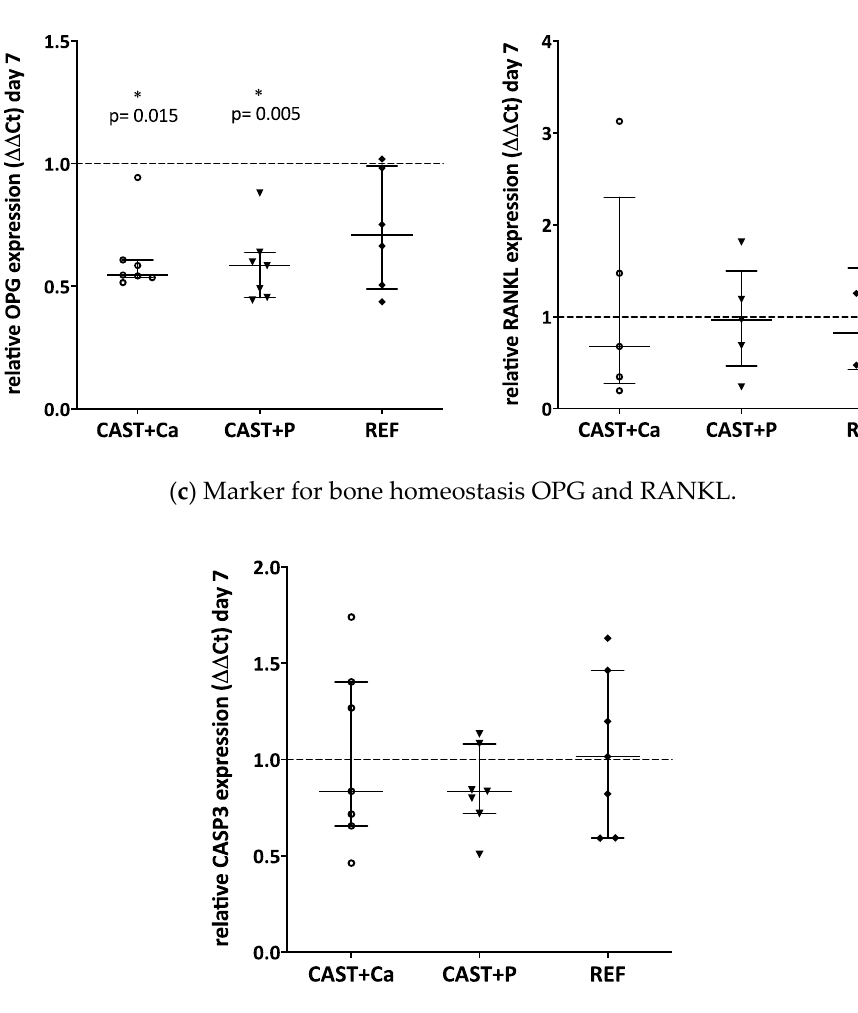
Figure 6. Gene expression analysis of primary human osteoblasts after cultivation for 7 days on a cast Ti6Al4V specimen without and with Ca- or P-ion implantation as well as a reference Ti6Al4V-specimen. Diagramed are scatterplots showing the interquartile range of the calculated ΔΔ Ct gene expression. ( a ) Shows results of regulators of the osteogenic phenotype. While RUNX2 (Runt-related transcription factor 2) is a key regulator in osteoblast differentiation, SP7 (Osterix) is a regulator of osteogenic differentiation and enhances the effect of RUNX2. ( b ) Presents the gene expression of differentiated osteoblasts. COL1a1: collagen type I is the major structural protein of bone. ALP: alkaline phosphatase is needed for mineralization of bone matrix and BGLAP: osteocalcin is needed to build hydroxyapatite crystals within the bone matrix. ( c ) Markers for bone homeostasis. OPG: osteoprotegerin is a decoy receptor for RANKL (receptor activator of nuclear factor kappa- Β ligand), while RANKL normally binds to RANK in order to stimulate bone resorption by osteoclasts. ( d ) Marker for the apoptotic process. CASP3: caspase 3 is a predominant caspase and regulates cell apoptosis. Gene expression was normalized in osteoblasts cultivated on cast surfaces without ion implantation. All gene expression data were normalized internal to HPRT1 as a housekeeping gene. Statistical analysis by one-way ANOVA with Kruskal–Wallis and Dunn’s post hoc test. The significance level was set to p < 0.05 (*). Ca: Ca-ion; P: P-ion. Ion dose 1e − 16 cm 2 , implantation energy 30 keV; n = 7.